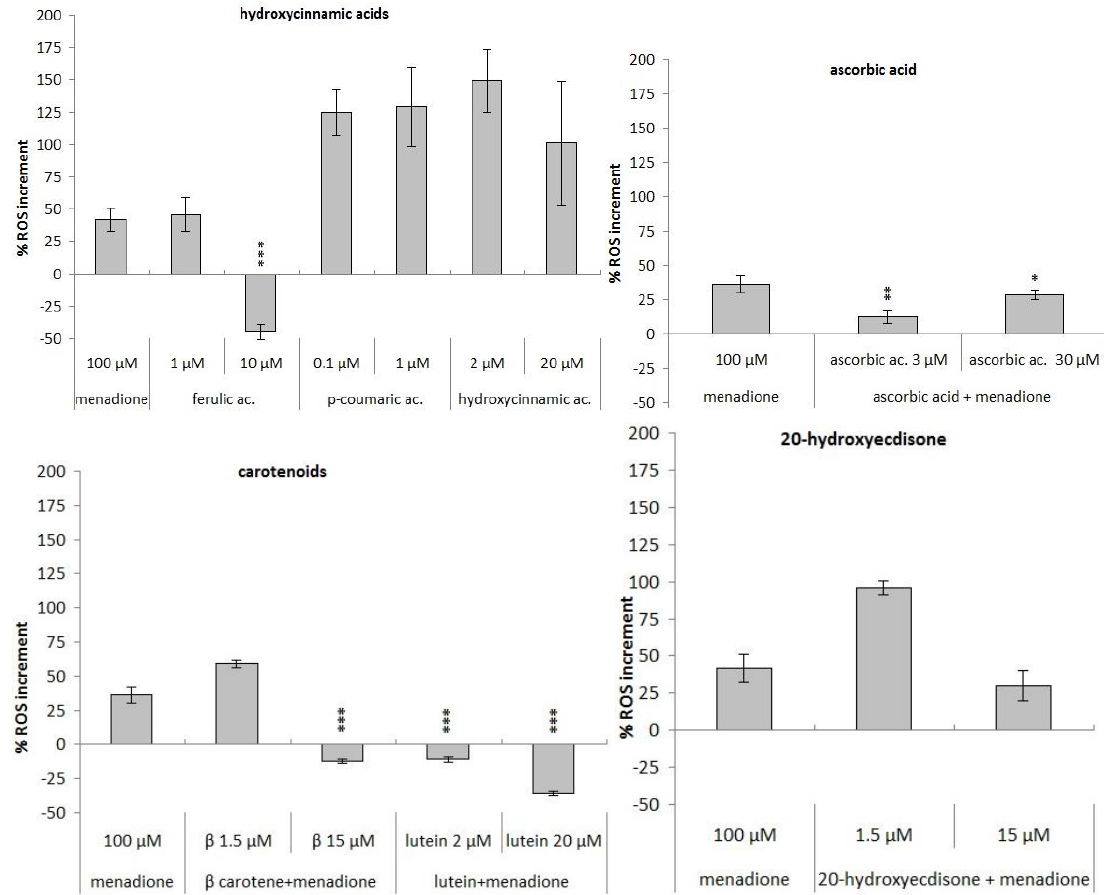
Figure 4. Evaluation of antioxidant ability of the phytochemicals to counteract the intracellular ROS levels caused by 24 h treatment with menadione oxidative insult (100 µ M) on HT29 cell line, expressed as ROS increment % (* p < 0.05; ** p < 0.01; *** p <